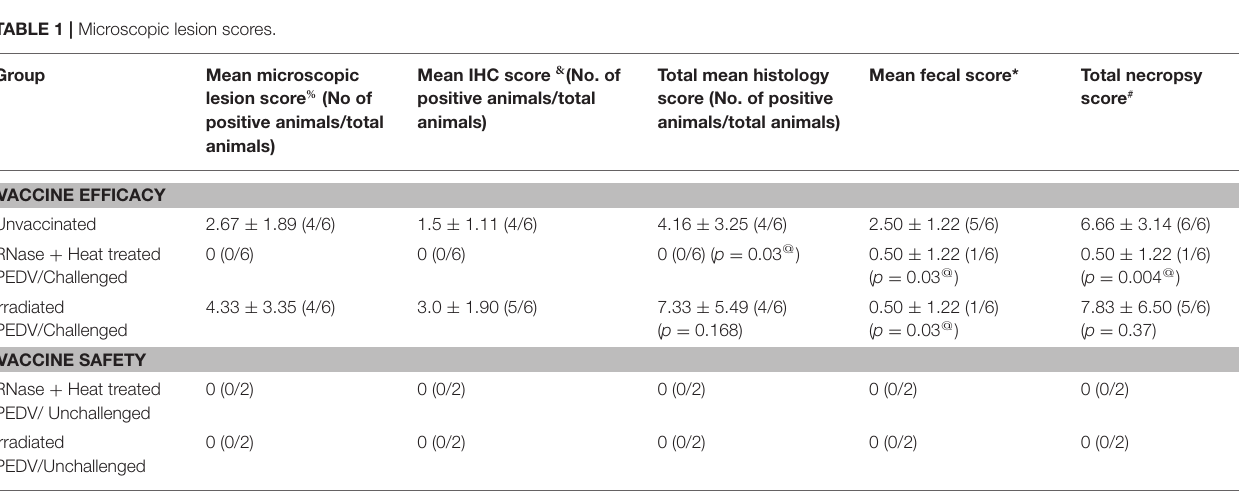
TABLE 1 | Microscopic lesion